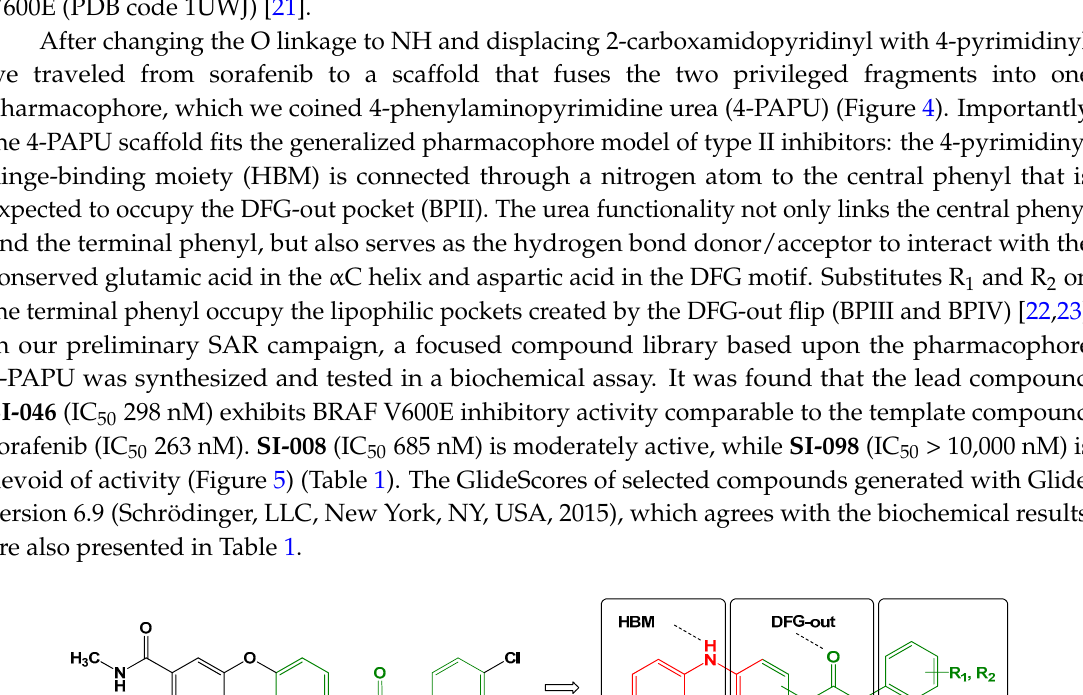
Figure 4. Evolution of type II kinase inhibitor pharmacophore 4-PAPU based upon privileged fragments of PAP (colored red) and unsymmetrically disubstituted urea (colored green). Potential hydrogen bond interactions are depicted as dashed lines.